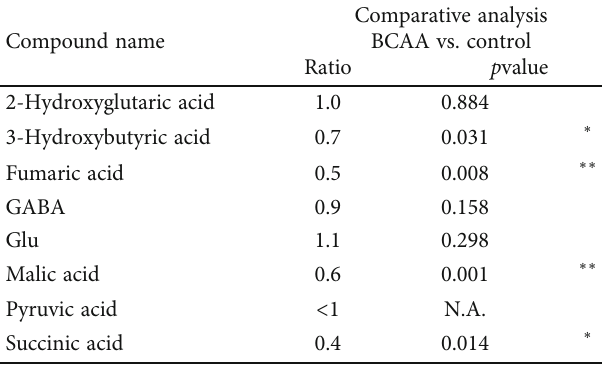
Table 2: Levels of metabolites related to butyric acid metabolism. Compound